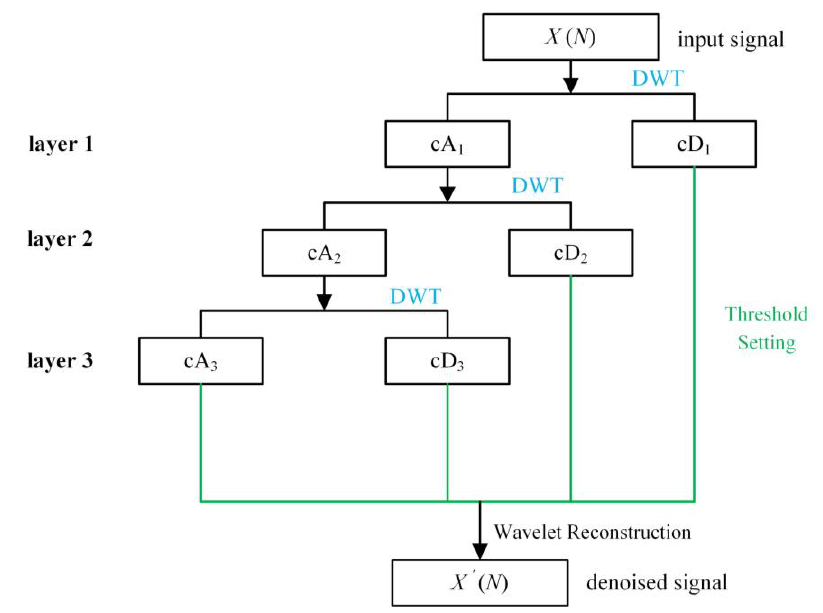
Figure 1. Schematic diagram of the Mallet algorithm.